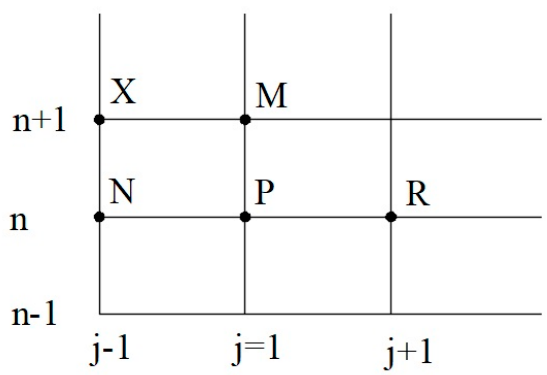
Figure 2. Schematic diagram of the grid points of the finite difference method.